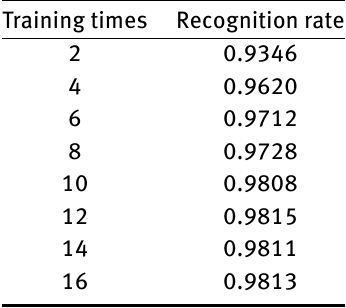
Table 5: Relationship between training times and recognition rate of the original WWN-7